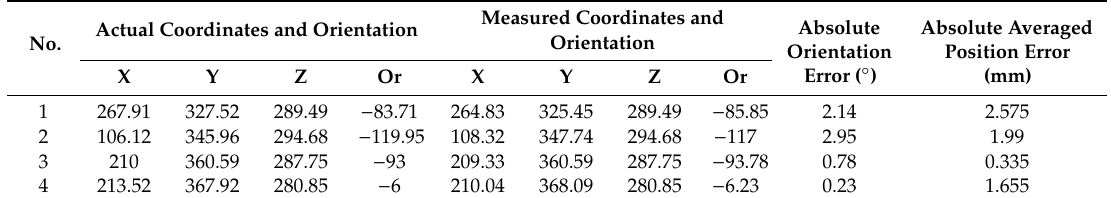
Table 3. Test results of object position and orientation.